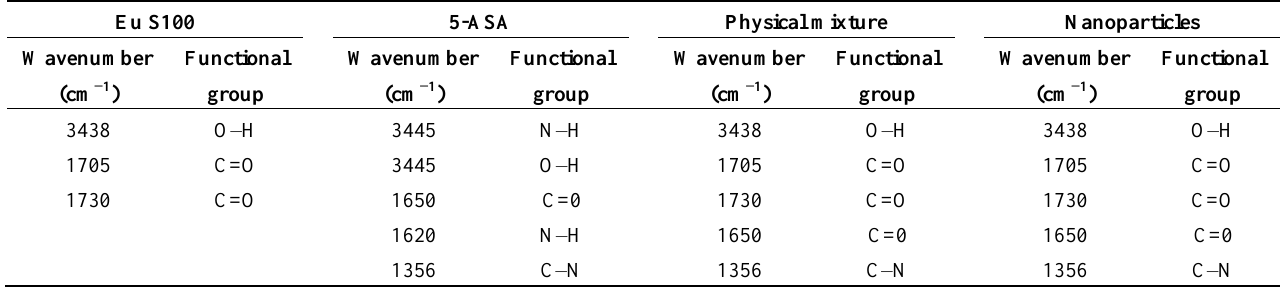
Table 2. Shows wavenumber (cm −1 ) and functional group for 5-ASA, Eu S100, physical mixture and nanoparticles (12 MPa, 35 °C, 1.0 mg/mL, 1.0 mL/min) using